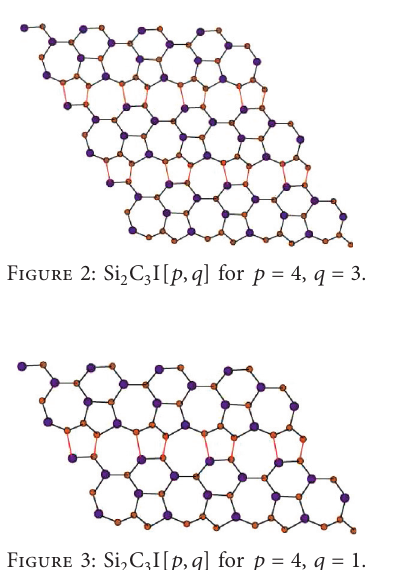
C I [ p,q ] for p � 4, q � 1. 2 3